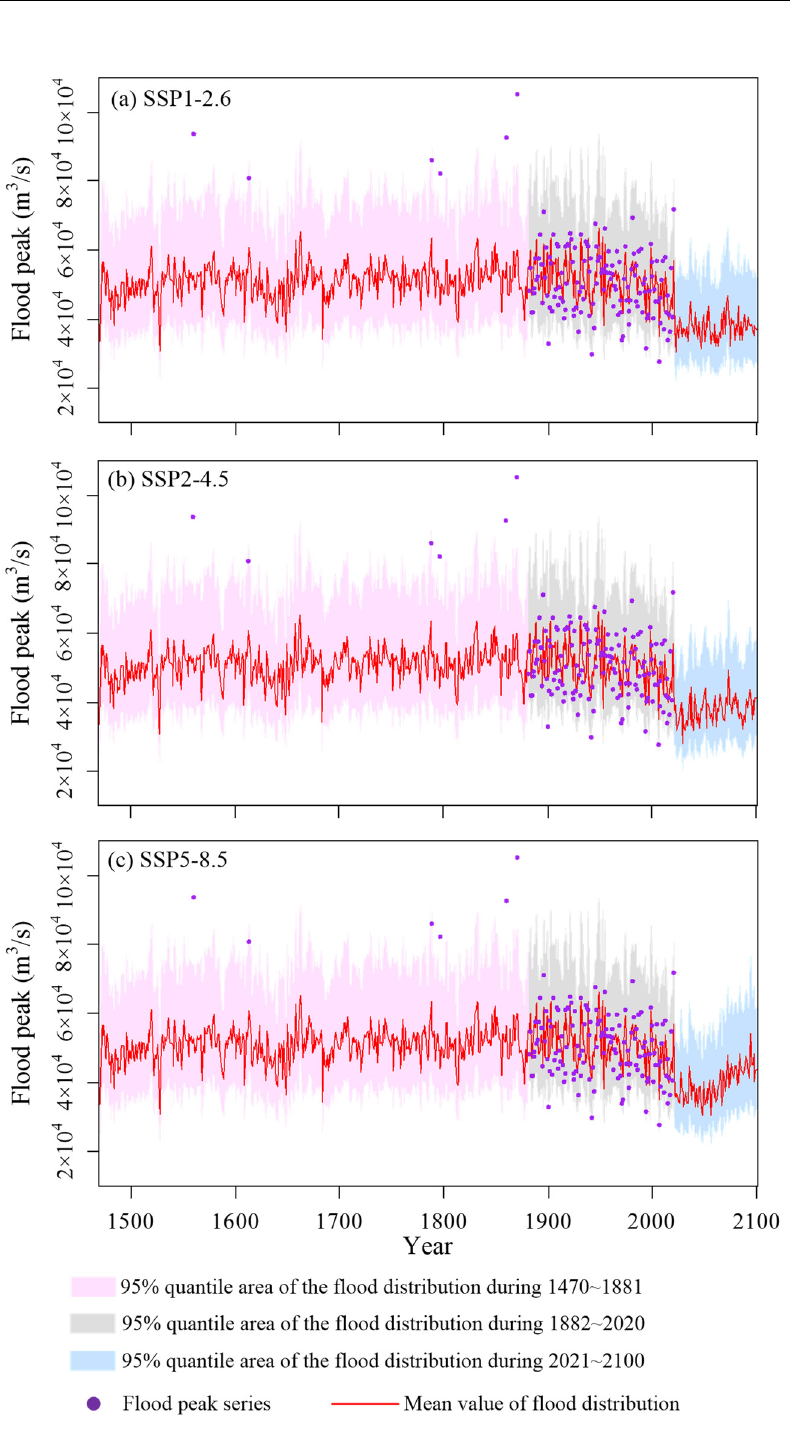
Figure 5. Evolution of the distribution of the dam-site flood peak of the TGR considering the reservoir regulation and SPA. Panels ( a – c ) display the results for emission scenarios SSP1-2.6, SSP2-4.5 and SSP5-8.5, respectively. Table 3. Parameters of the 5-D vine copula for the dam-site floods of the TGR. Bivariate Pair Copula